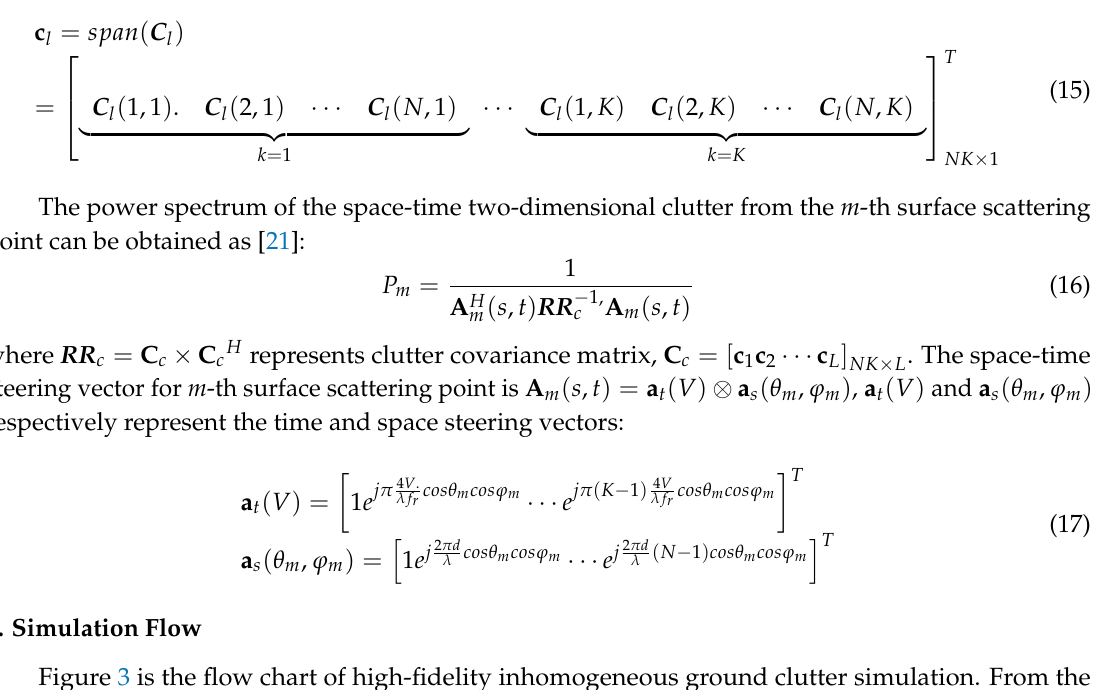
Figure 3 is the flow chart of high-fidelity inhomogeneous ground clutter simulation. From the figure, the key steps of the high-fidelity inhomogeneous clutter simulation method for airborne phased array PD radar aided by DEM and DLCD are: